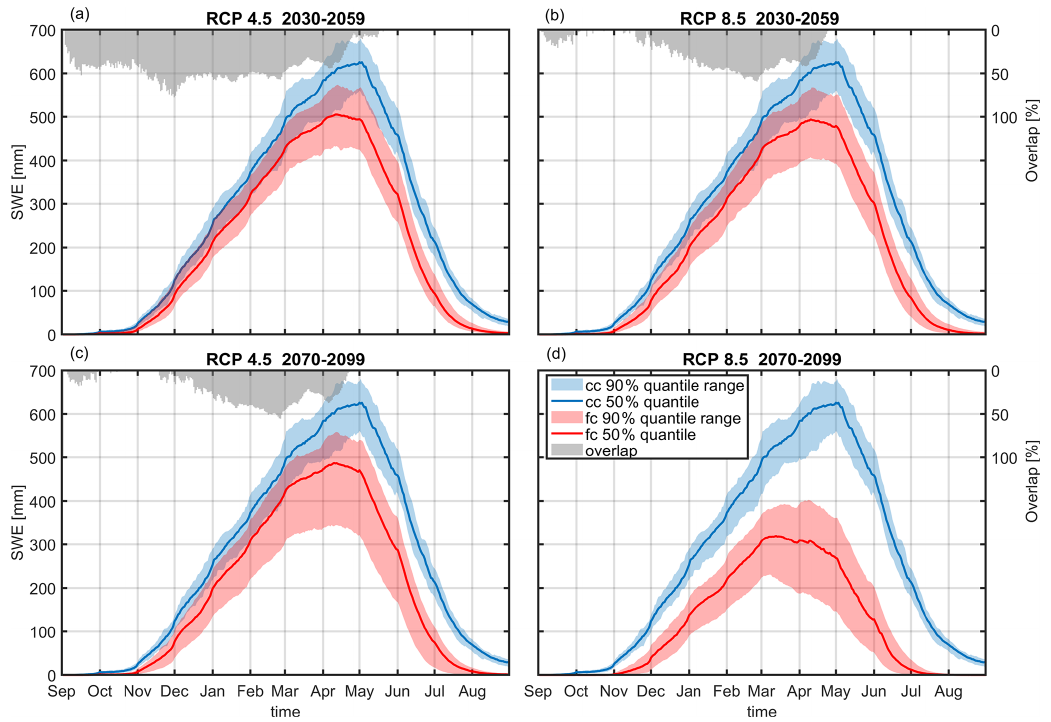
Figure 7. Areal mean seasonal SWE development under current (cc) and future climate (fc) for different emission scenarios and time horizons. Plotted are the 5th, 50th and 95th percentiles of climate period mean values stemming from 50 (current climate) and 500 climate periods (future climate with 50 realizations of 10 climate models). The overlap indicates how much of the current-climate natural variability is overlaid by the future-climate uncertainty